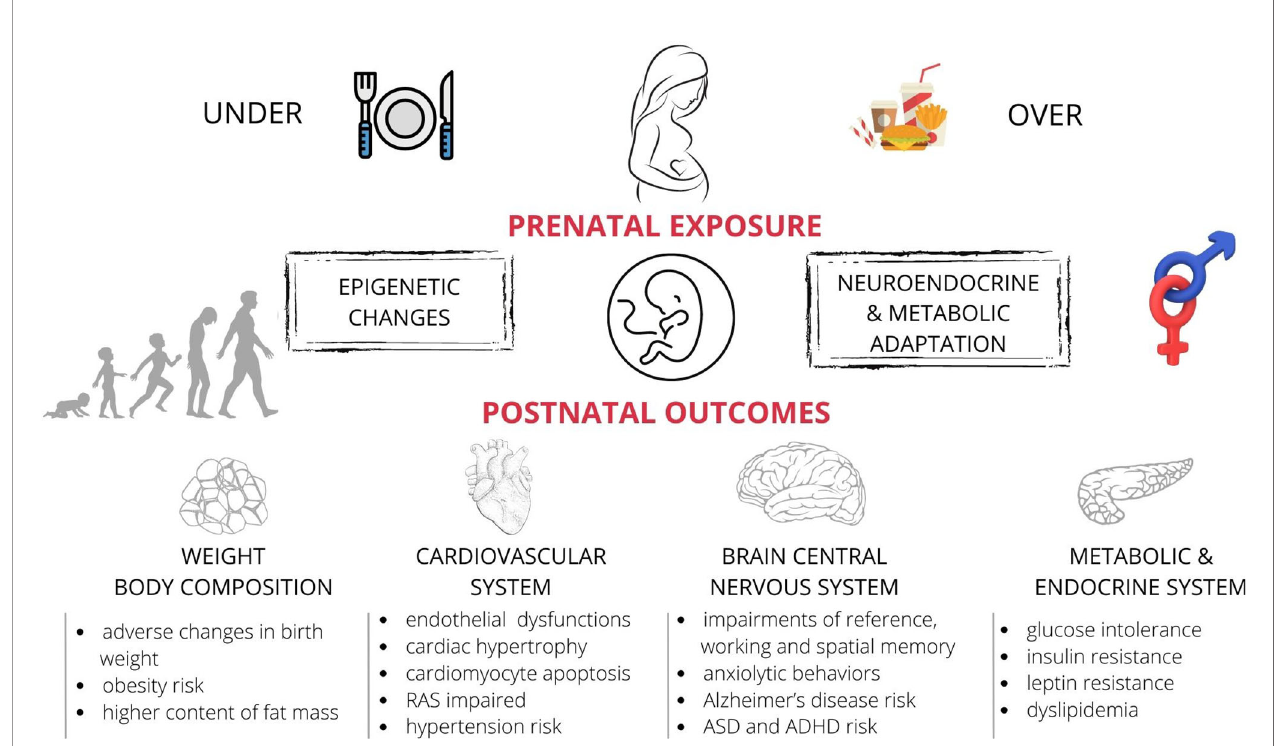
FIGURE 1 | The effects of maternal nutritional imbalance (under- and overnutrition) on offspring during foetal development. Short and long-term negative outcomes (observed both in humans and laboratory animals) include the adverse effects of unbalanced diet on offspring ’ s metabolism, hormonal state, changes in the body weight and fat content, and abnormal function of the nervous and cardiovascular systems. These effects appear to be sex-speci fi c. ASD, autism spectrum disorder; ADHD, attention de fi cit hyperactivity disorder; RAS, the renin-angiotensin